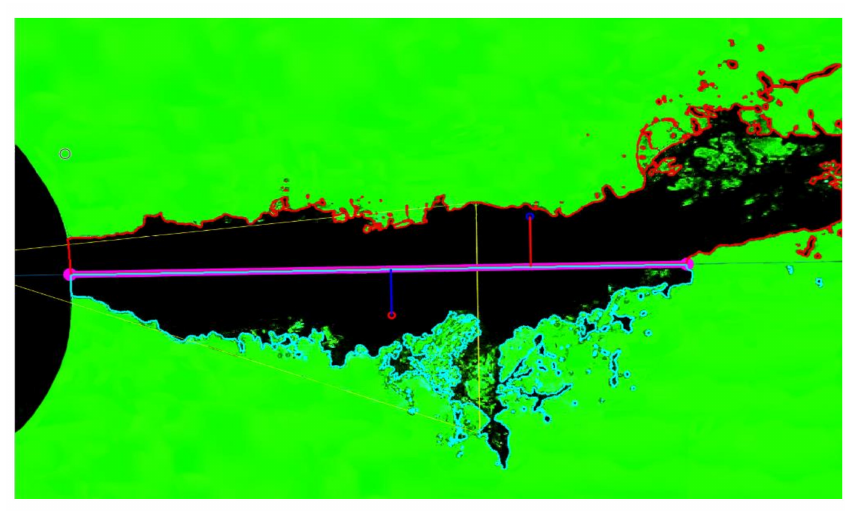
Figure 4. Post-processed microscopic